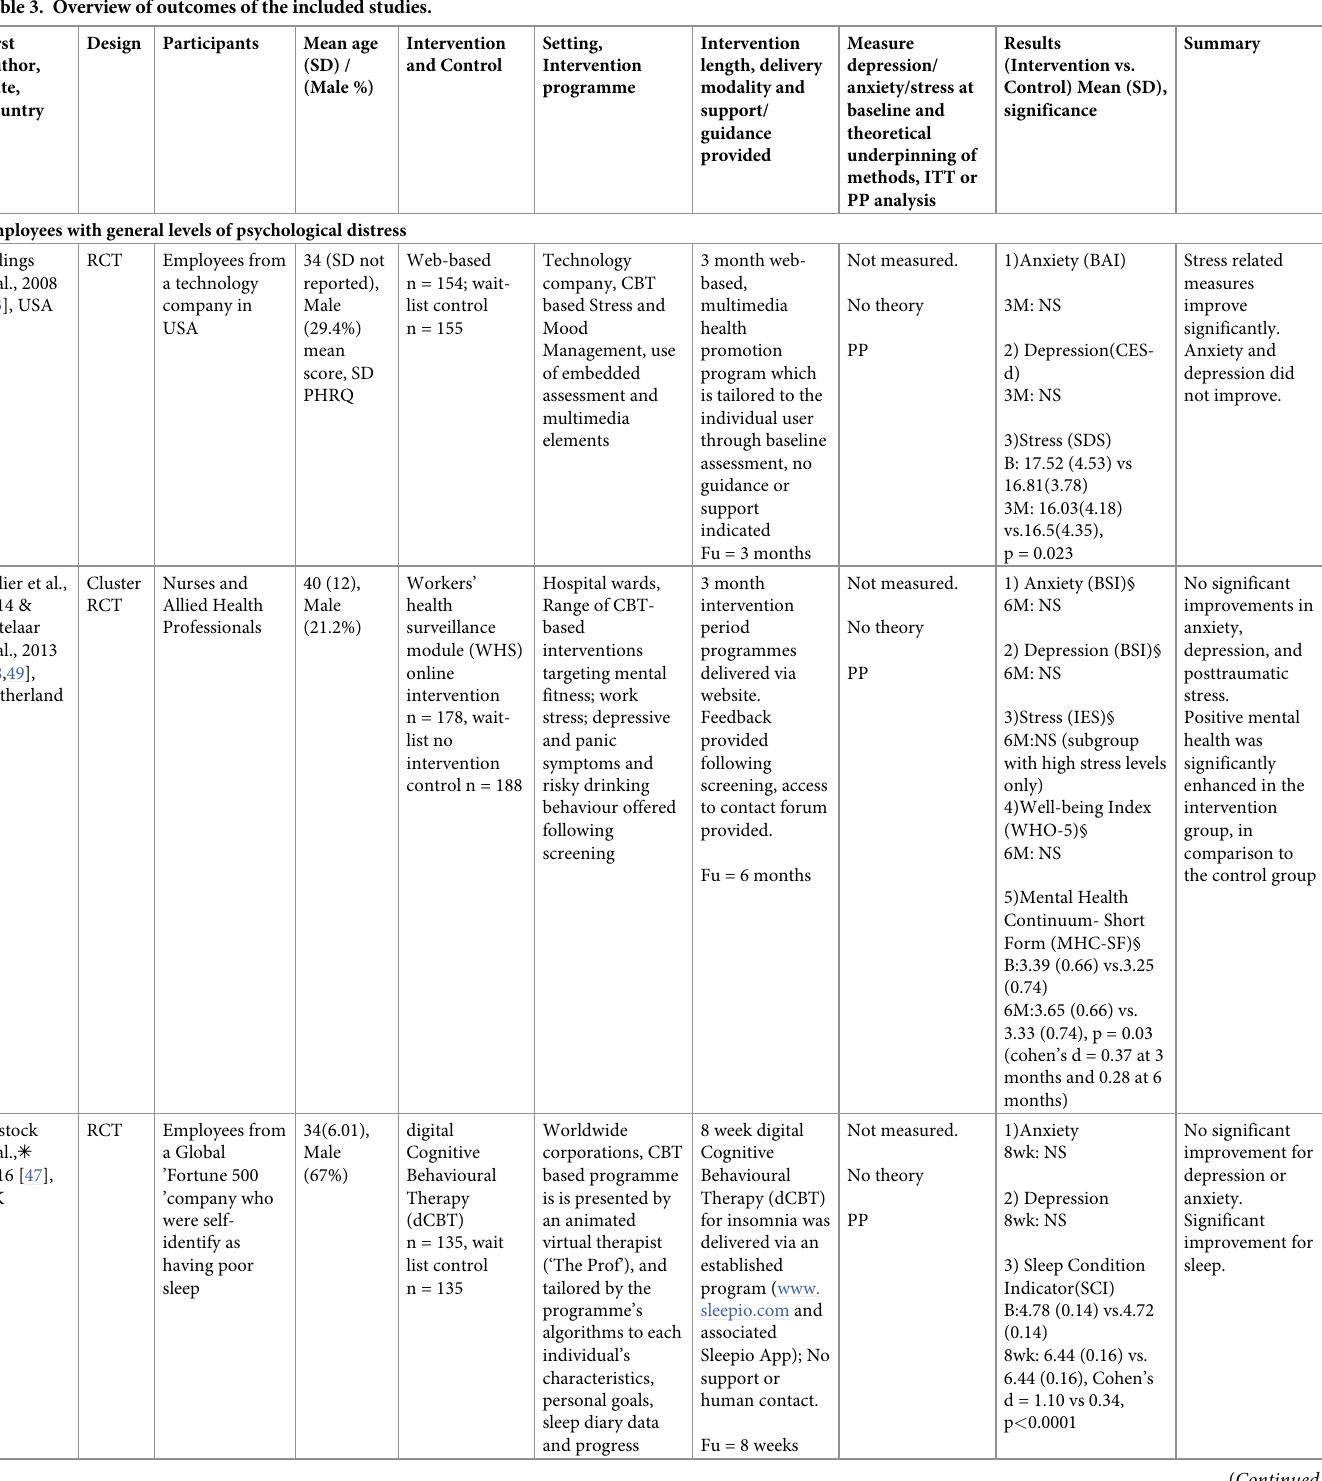
Table 3. Overview of outcomes of the included